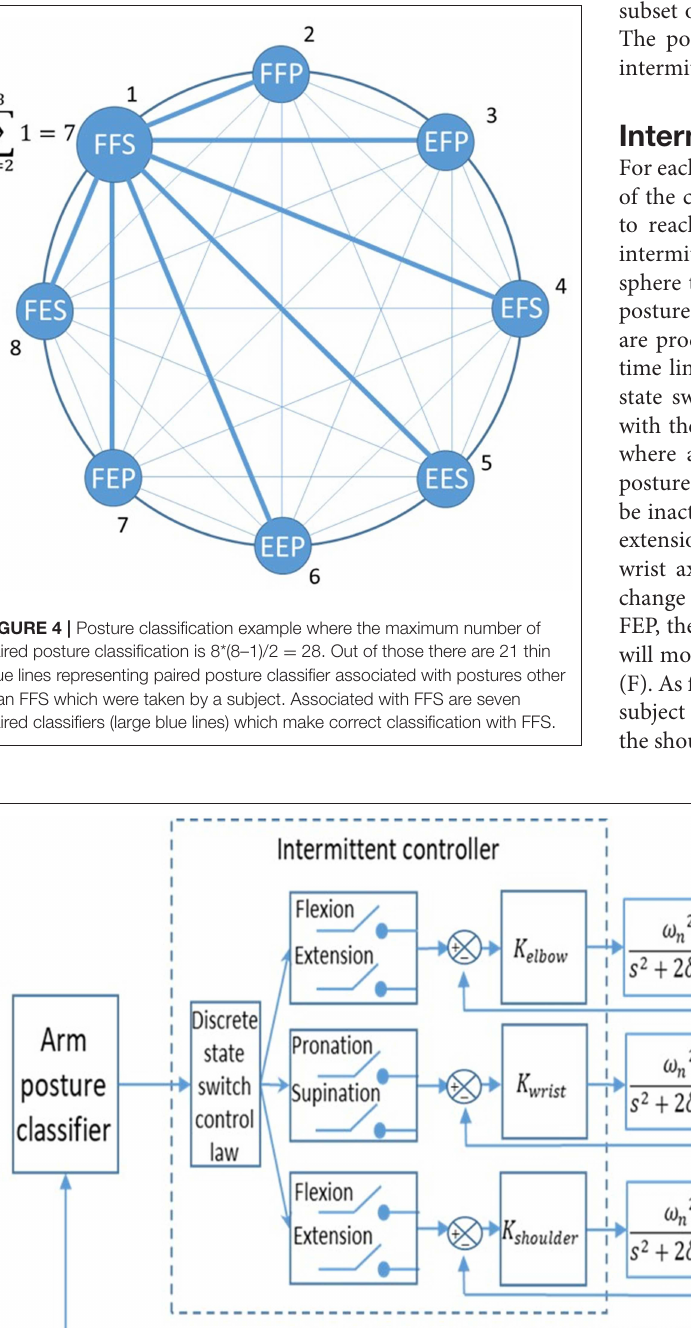
Frontiers in Neurorobotics |